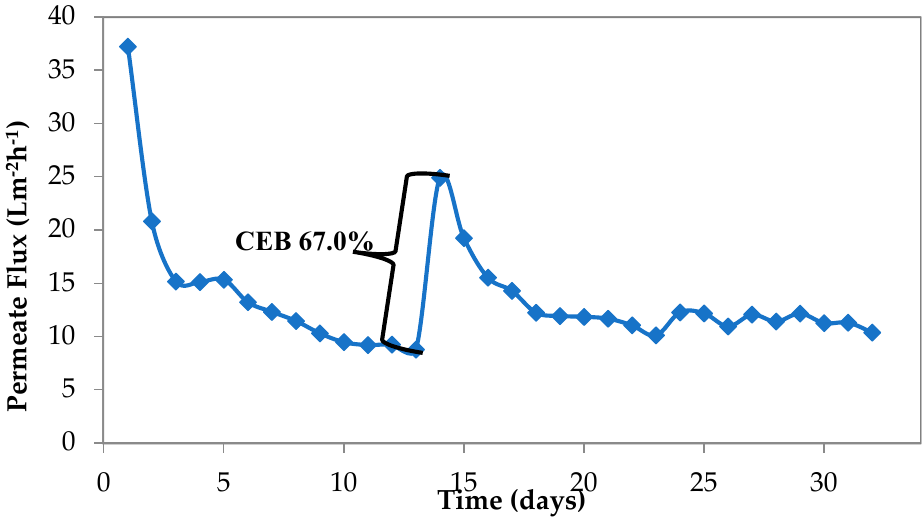
Figure 4. Temperature corrected flux versus time plot obtained using AS-2 at a concentration of 40 mg/L and a MLSS of 9–13 g/L.